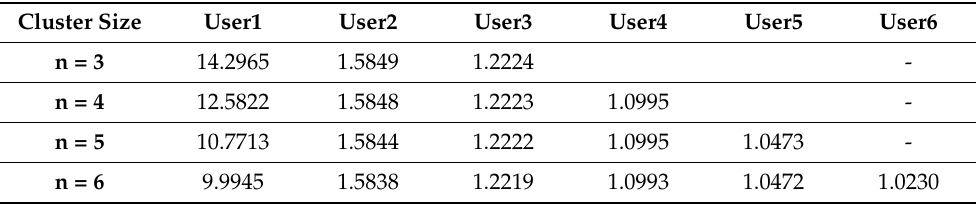
Table 4. Normalized IDR Monte-Carlo simulation analysis in bits per sec per Hertz for GP-based optimal power allocation in downlink TDMA-RIS-NOMA clusters.